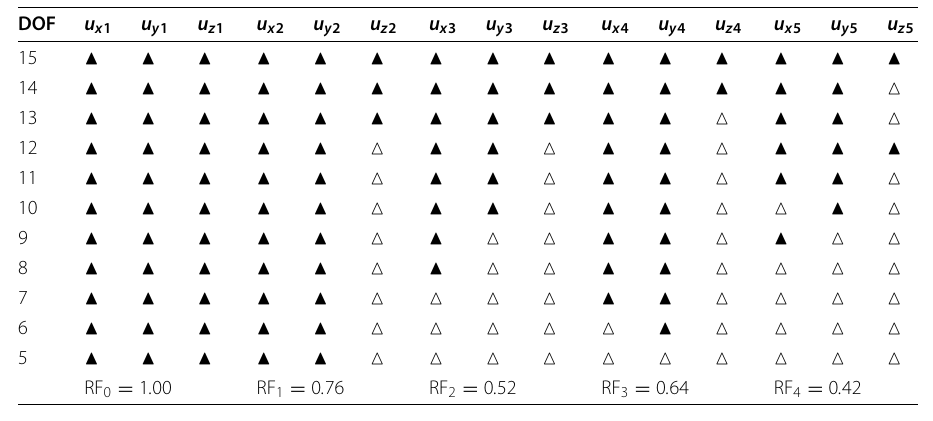
Table 8 BTD models for 0/90/0/90, R/a = 5 , a/h = 10